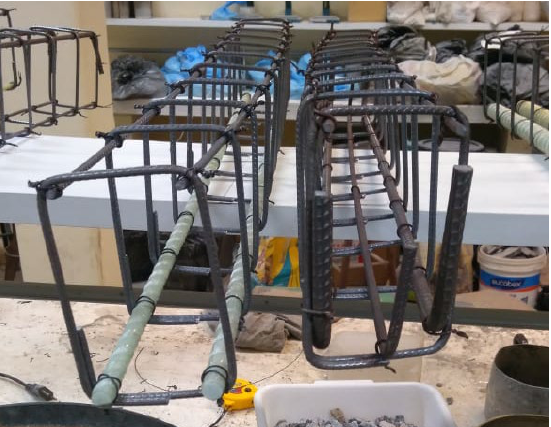
Figure 4. Reinforcement of beams VV37 and